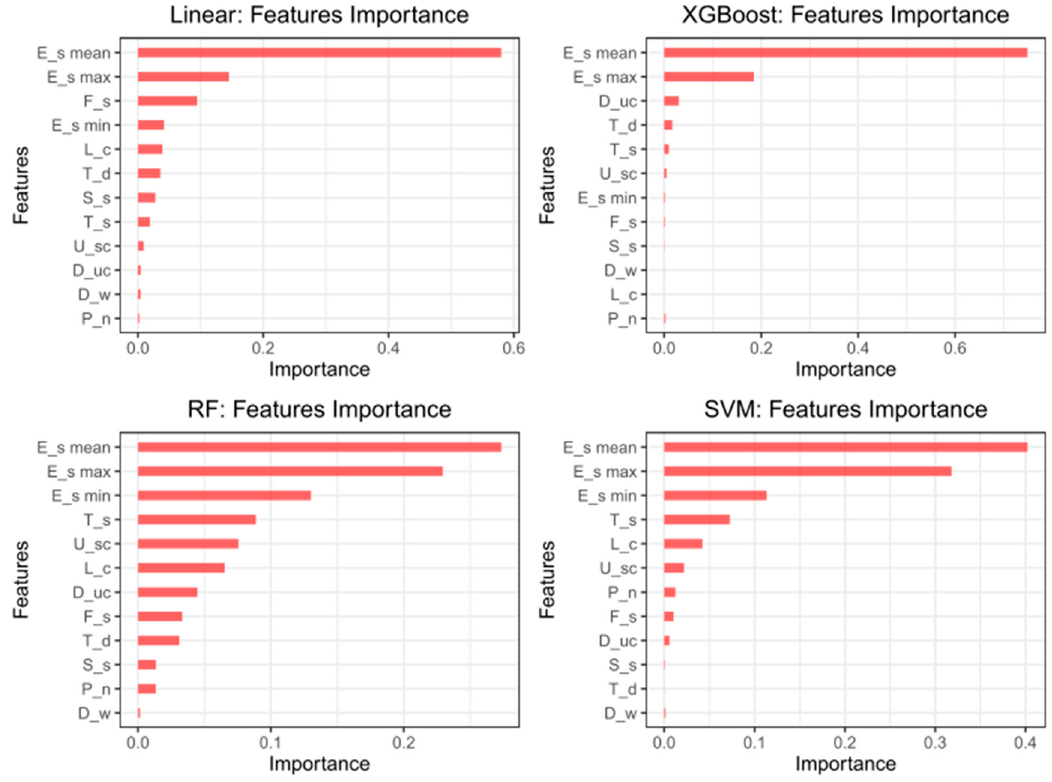
Figure 11. Feature importance comparisons for each method.